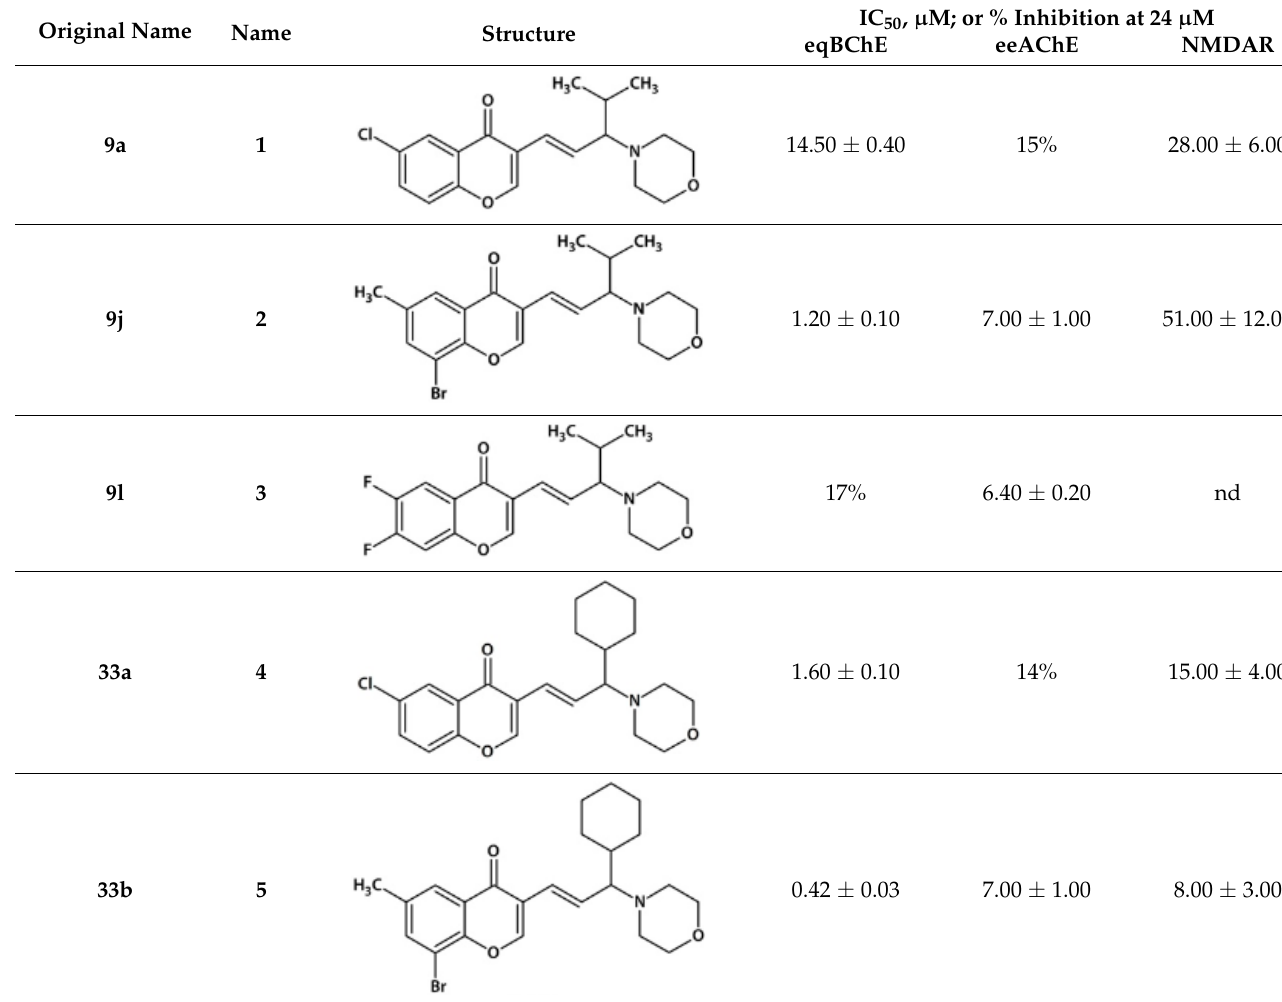
Table 1. Chromone-containing allylmorpholines selected for this study and their biological activity [11].